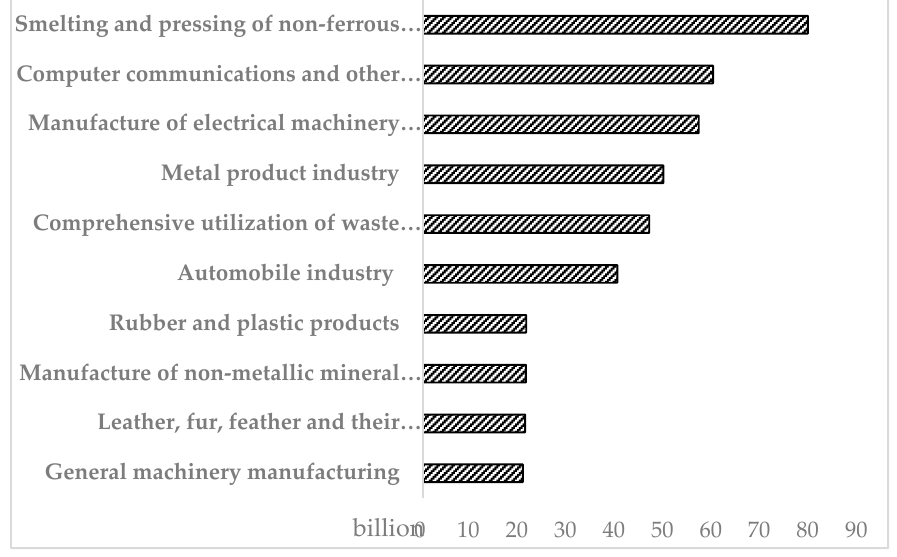
Figure 10. GVIOADS by industry (top 10).